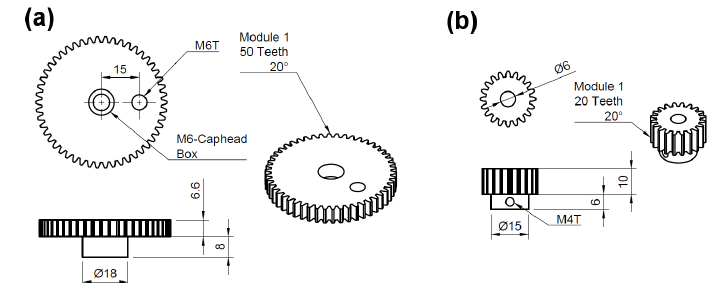
Figure 11. Schematic representation of the M1 50 theeth ( a ) and M1 20 theeth ( b ) gears used. Sizes shown are just for reference and have not been optimized. The design will require adjustments.